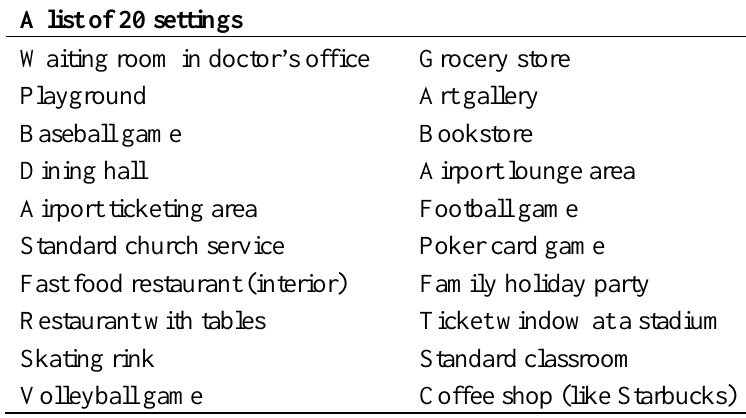
Table 1. The list of the 20 settings employed in the pre-test ratings.